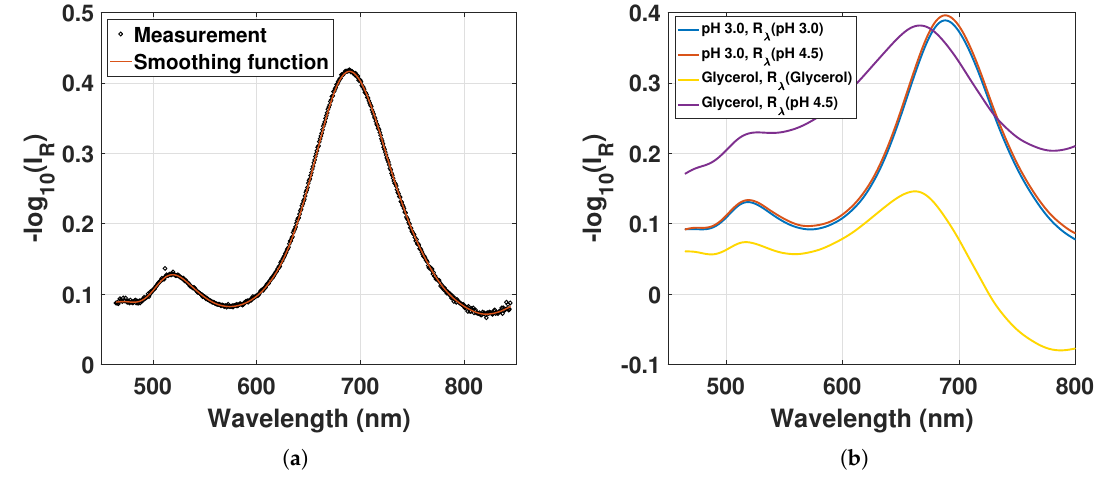
Figure 5. ( a ) Reflectance from the GNR-hydrogel with smoothing function, in pH 4.5 with R λ ( pH 4.5 ) ; ( b ) reflectance from the GNR-hydrogel in (1) pH 3.0 with R λ ( pH 3.0 ) and R λ ( pH 4.5 ) and (2) 40 wt% glycerol at pH 4.5 with R λ ( 40 wt% glycerol, pH 4.5 ) and R λ ( pH 4.5 )